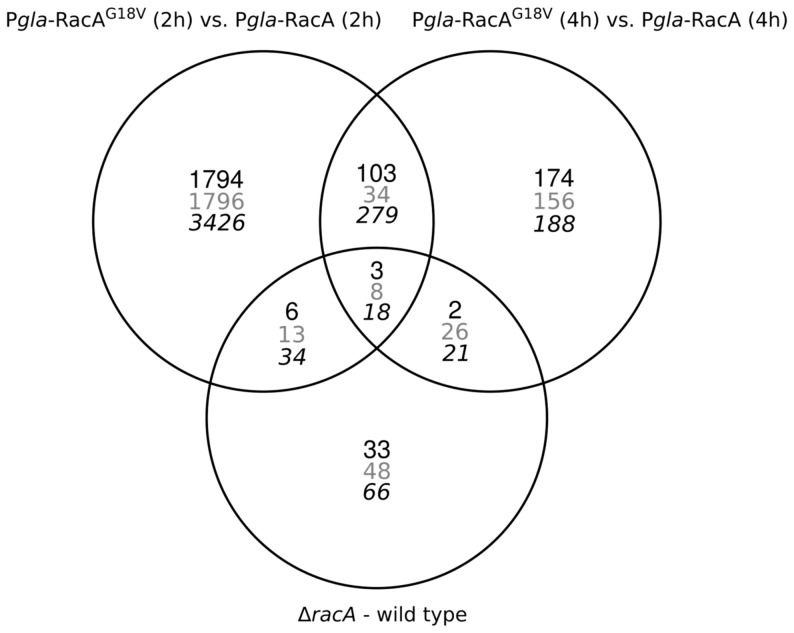
Venn diagrams of induced (black numbers), repressed (grey numbers) and up- or down-regulated (italics numbers) genes for the PglaA-RacAG18V/PglaA-RacA and ΔracA/N402 comparisons.